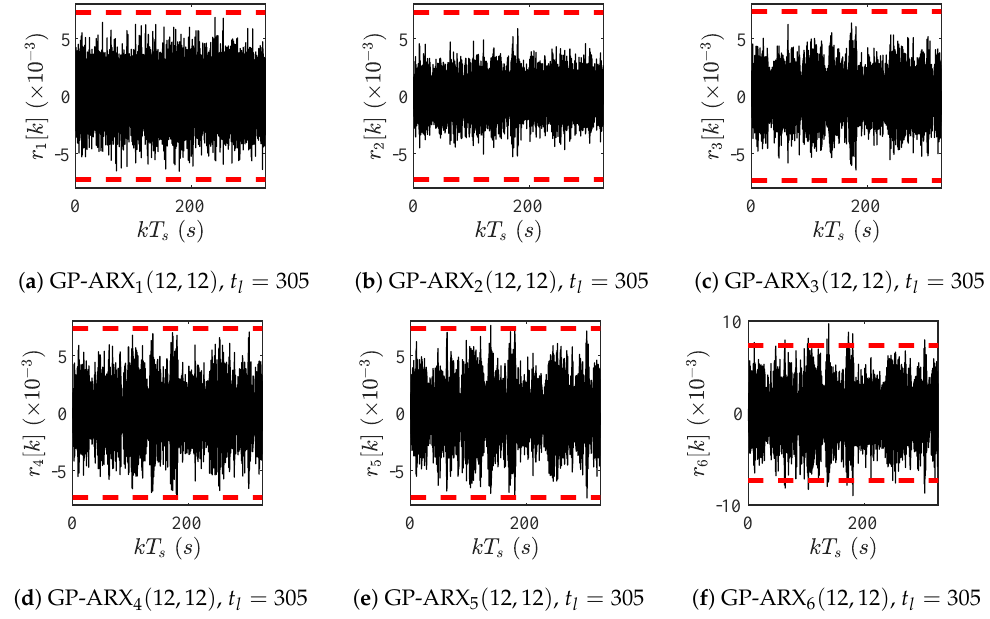
Figure 21. Shear frame: evolution of the residuals during a long time-scale instant from the validation